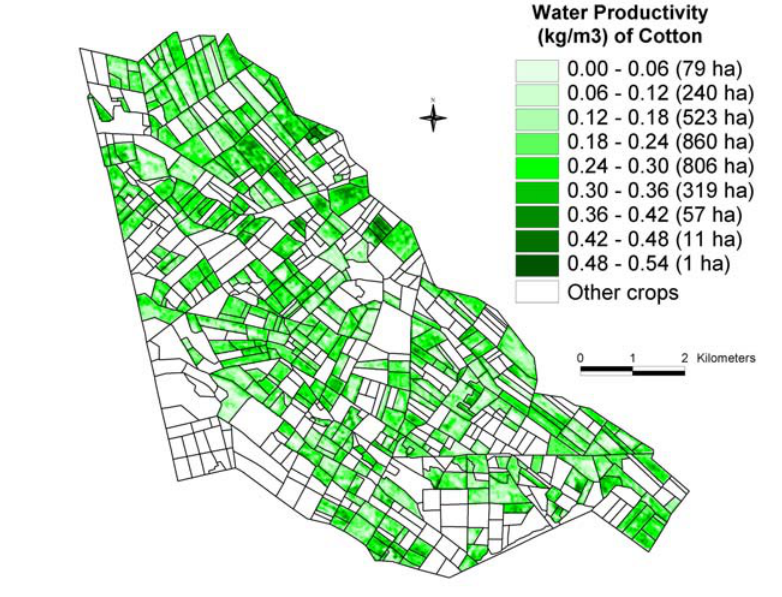
Figure 13. Water productivity map (WPM) of the cotton crop in the Galaba study